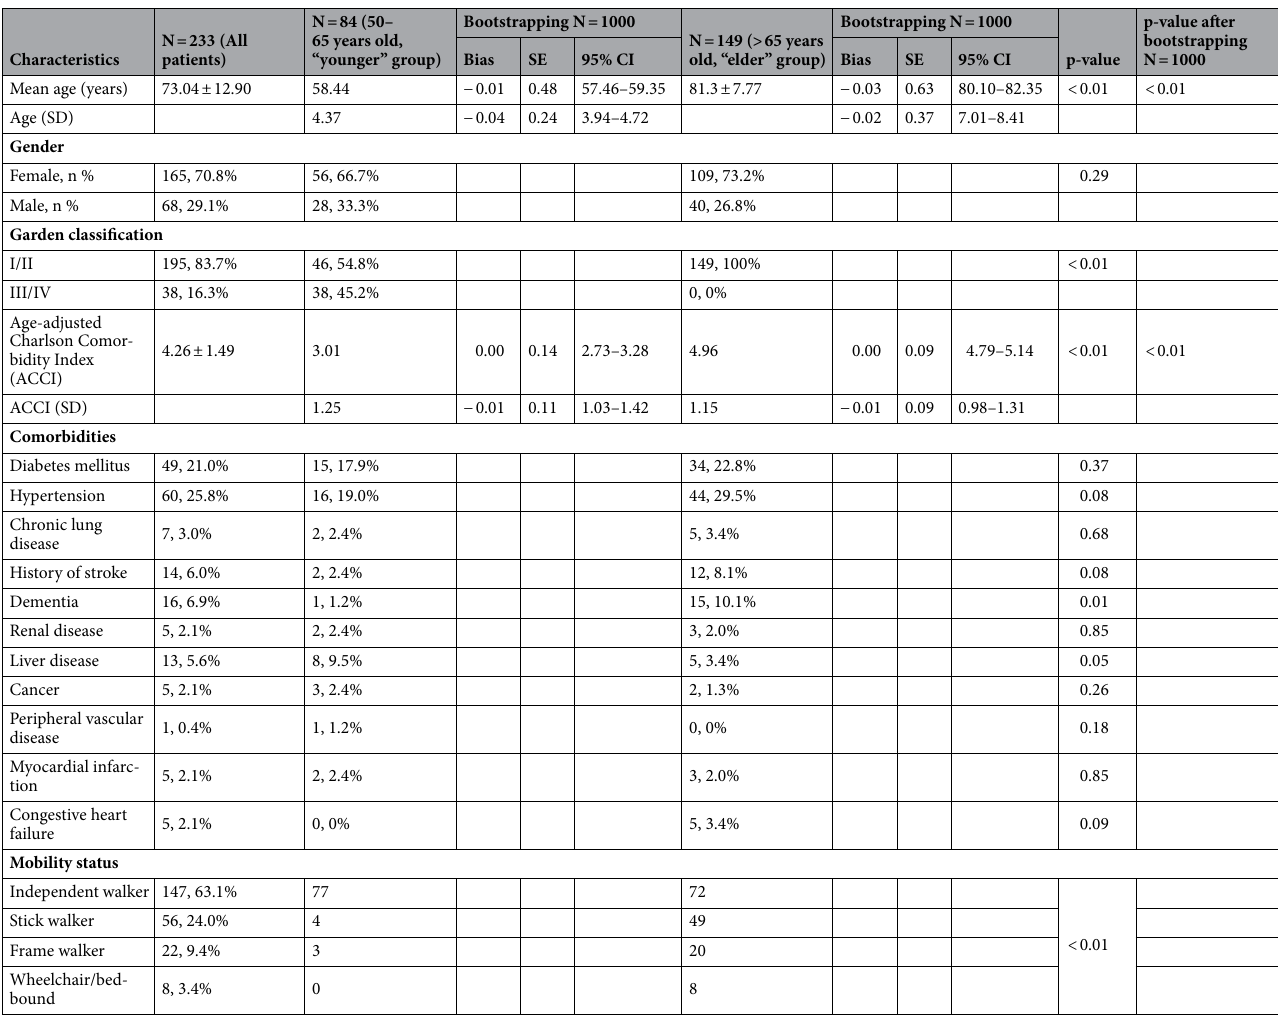
Table 1. Baseline characteristics of the